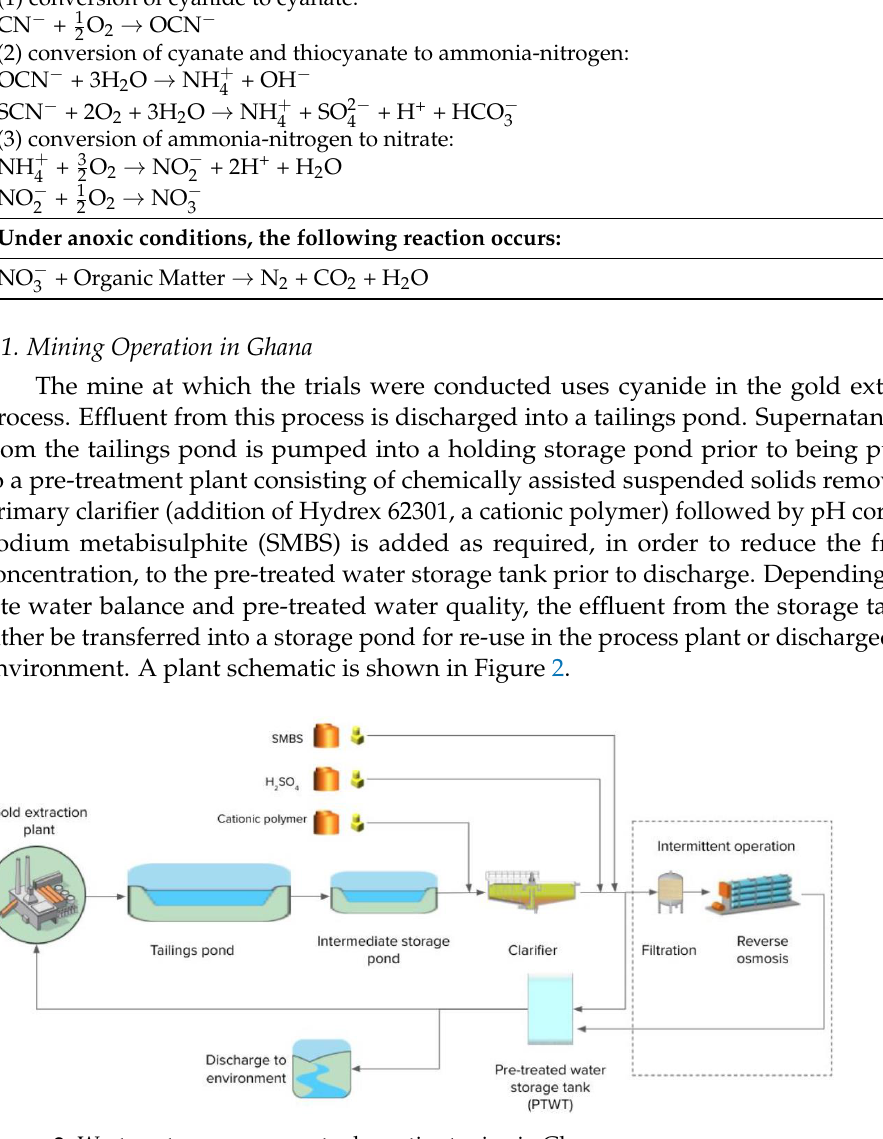
Figure 2. Wastewater management schematic at mine in Ghana.